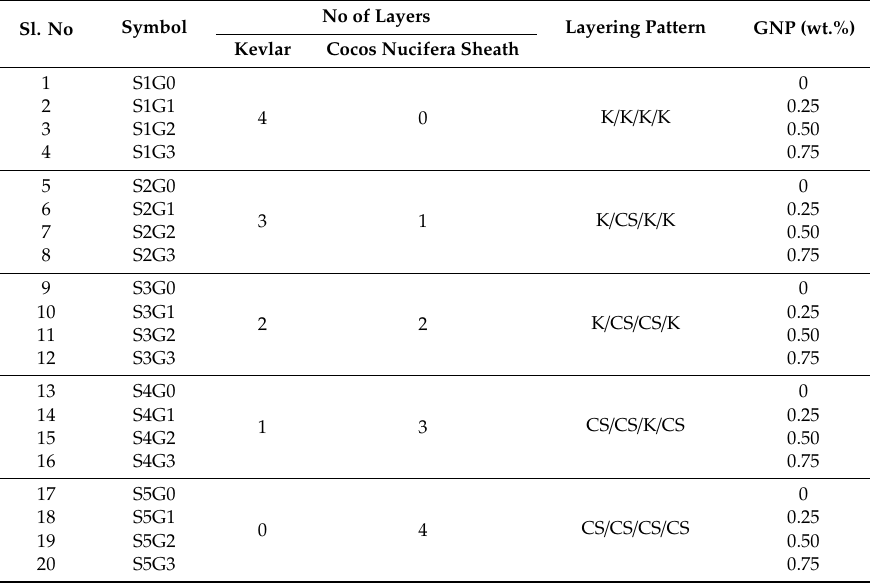
Table 3. The specification of the